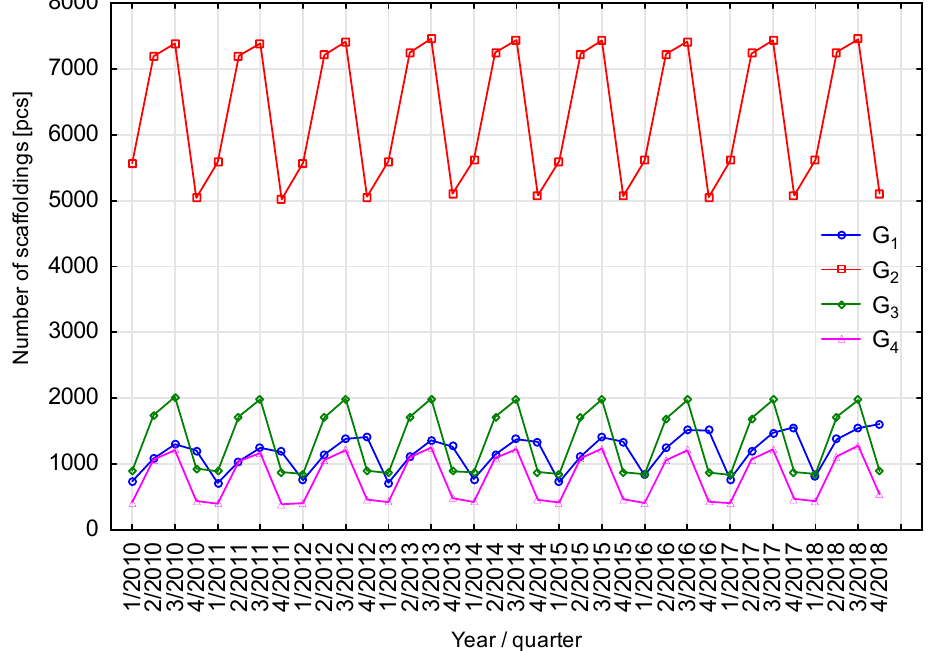
Figure 7. Number of scaffoldings in the Dolnoslaskie region (divided into groups G ) estimated using the neural network set.